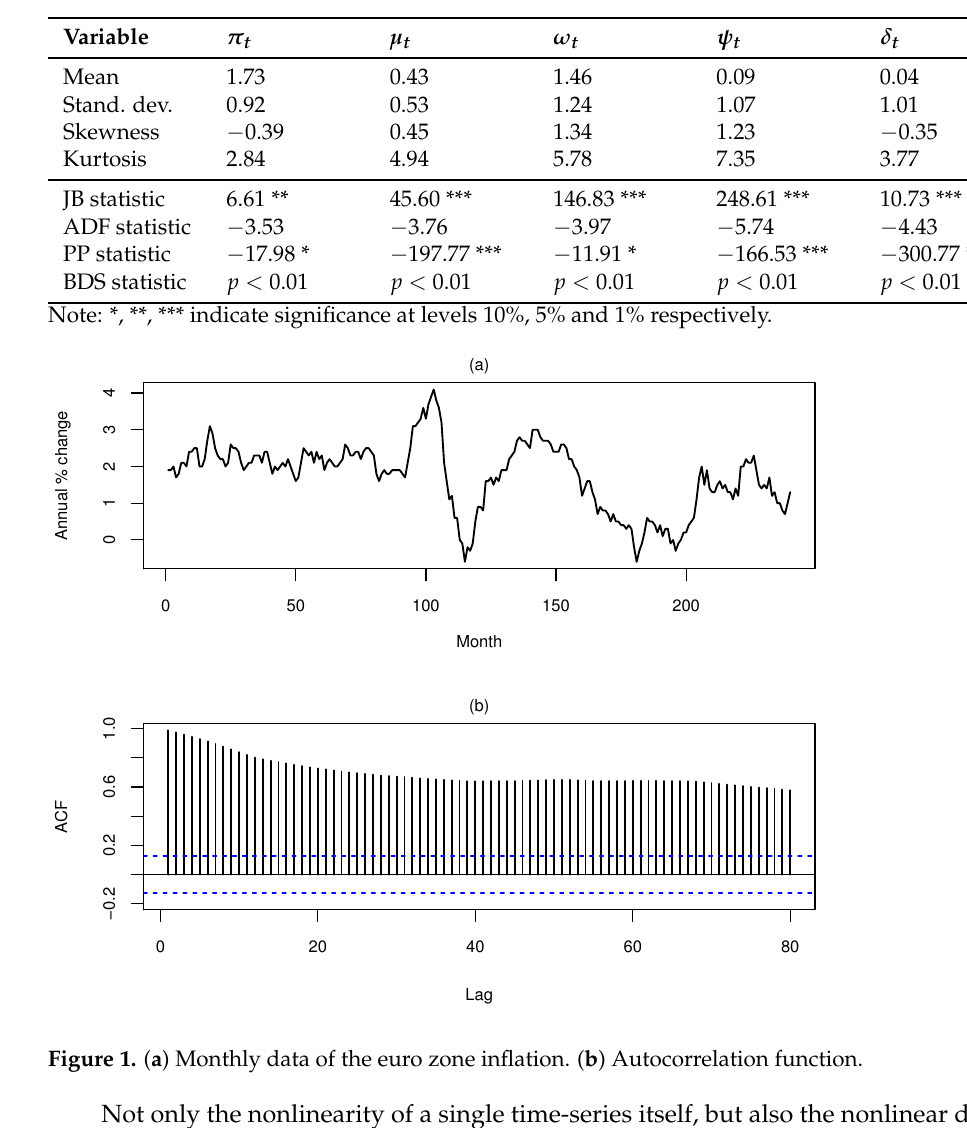
Table 2. Descriptive statistics of output and inputs with pre-estimation tests.